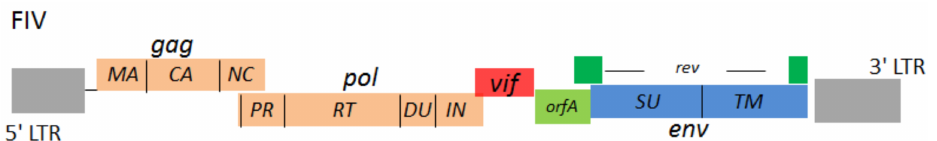
Figure 1. Cartoon representation of Feline immunodeficiency virus (FIV) genome structure. Two long terminal repeats (LTRs) locate at 5’ and 3’ termini. The structural genes of FIV are gag , pol , and env . The regulatory genes of FIV are vif , orfA and rev . The gag encodes virus structural proteins: matrix (MA), capsid (CA), nucleocapsid (NC). The pol encodes virus enzymes: protease (PR), reverse transcriptase (RT), integrase (IN) and dUTPase (DU). The env encodes virus envelope proteins: surface (SU) glycoprotein and transmembrane (TM)